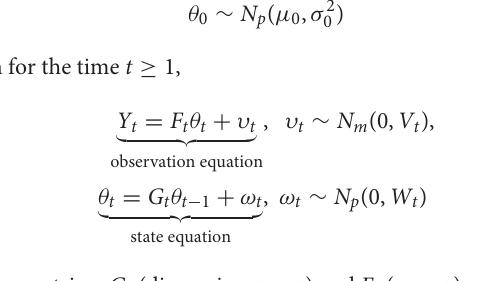
Frontiers in Systems Neuroscience |